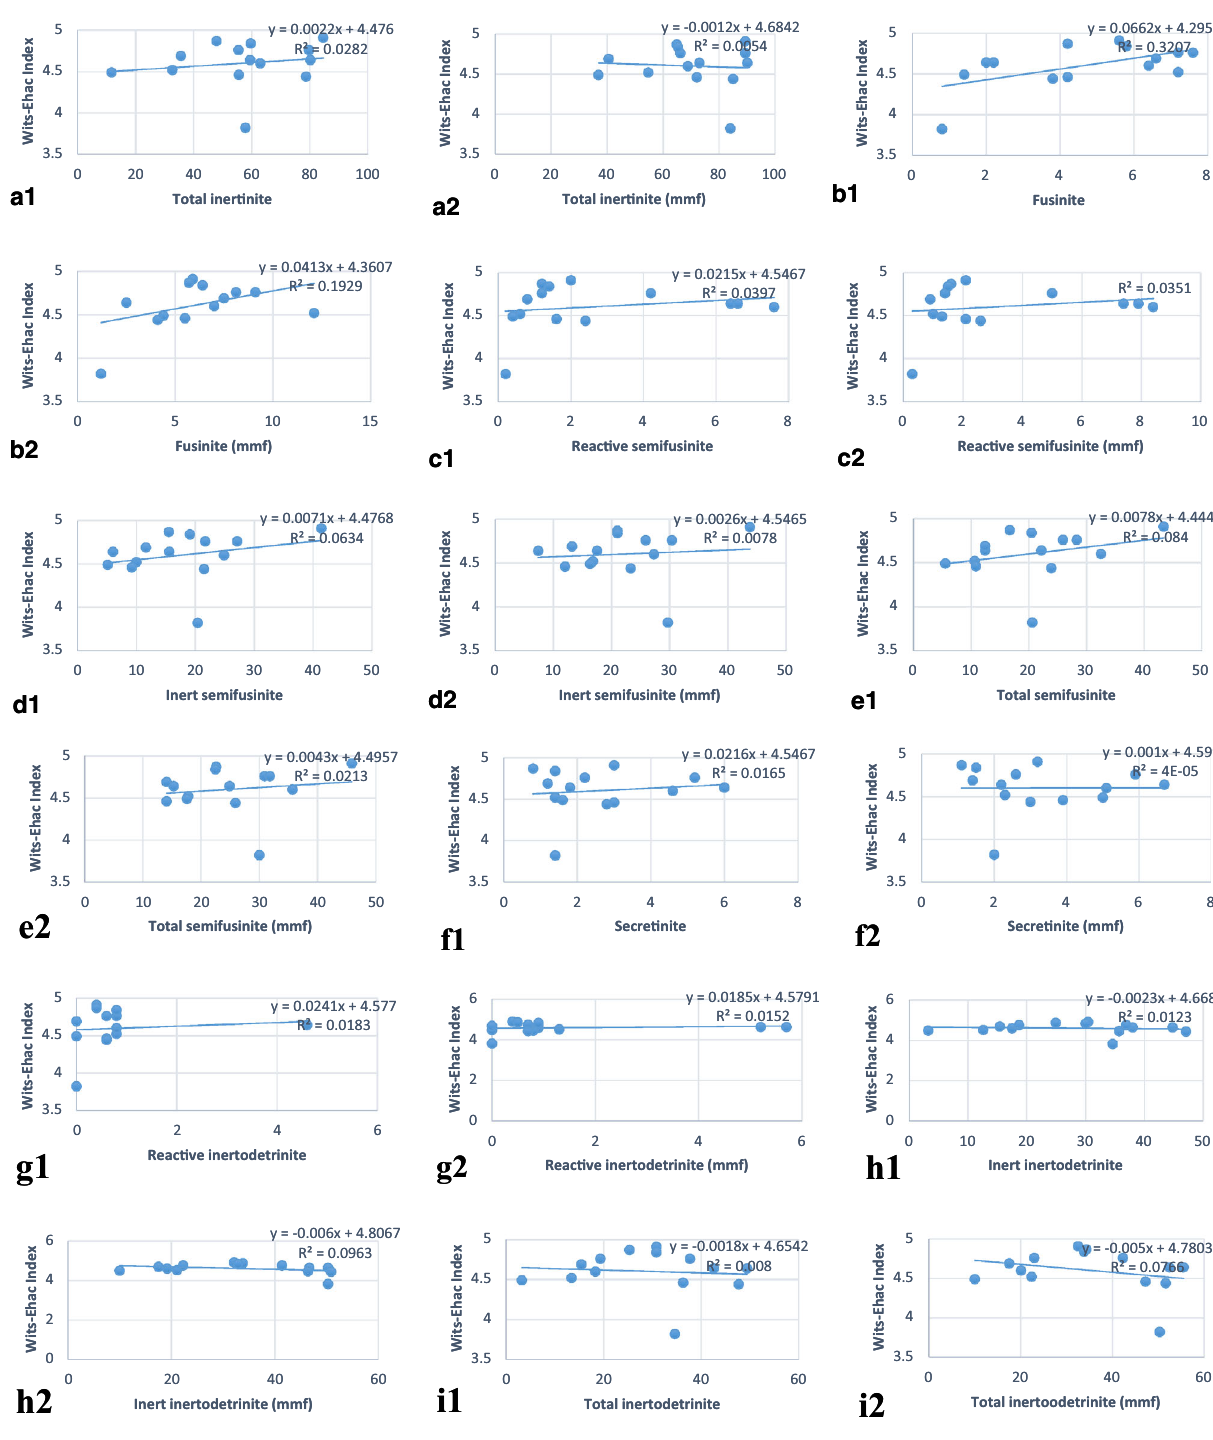
Fig. 5 Influence of total inertinite and its group on spontaneous combustion liability of